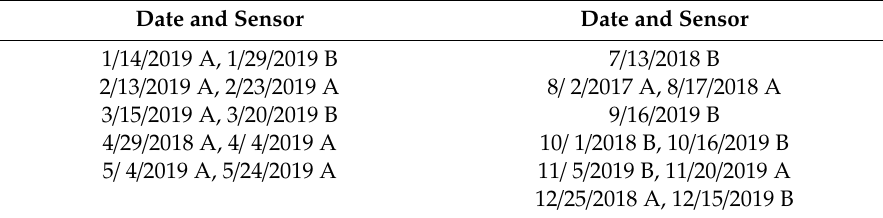
Table 1. Observation dates and Sentinel-2 satellite (A /